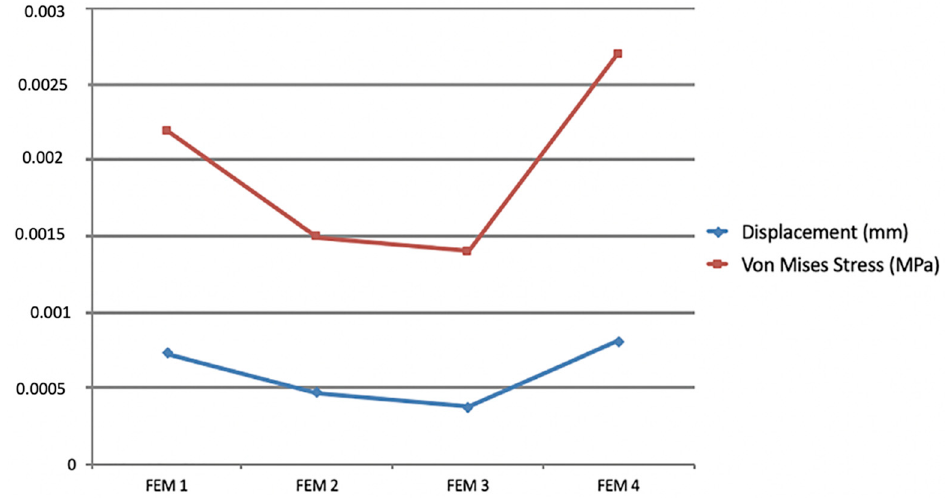
Figure 6. Maximum values for von Mises stress ( red ) and initial displacement ( blue ) for each variable tested (FEM 1, FEM 2, FEM 3, and FEM 4) on anterior